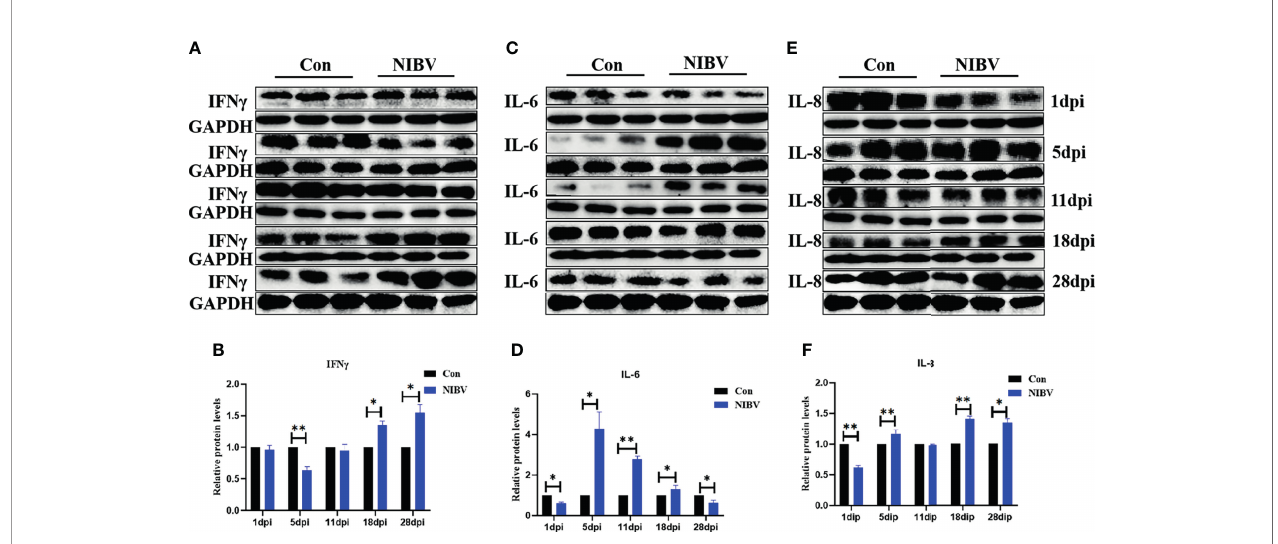
FIGURE 7 | (A, C, E) Protein band graph; (B, D, F) IFN- g , IL-6 and IL-8 protein expression levels. *(0.01 < P < 0.05), **(P < 0.01), (N=3).